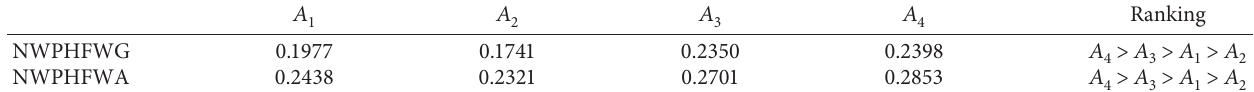
Table 8: The collective evaluation values of the alternatives and ranking.